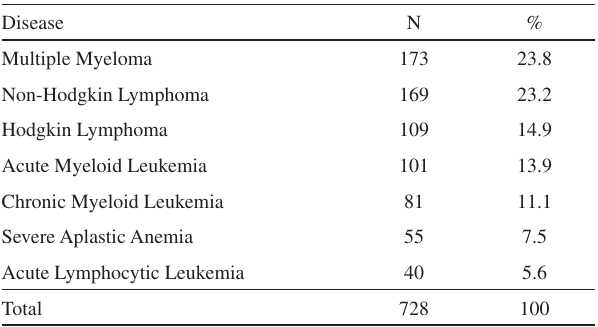
Table 6 - Indications for adult hematopoietic stem cell transplantation